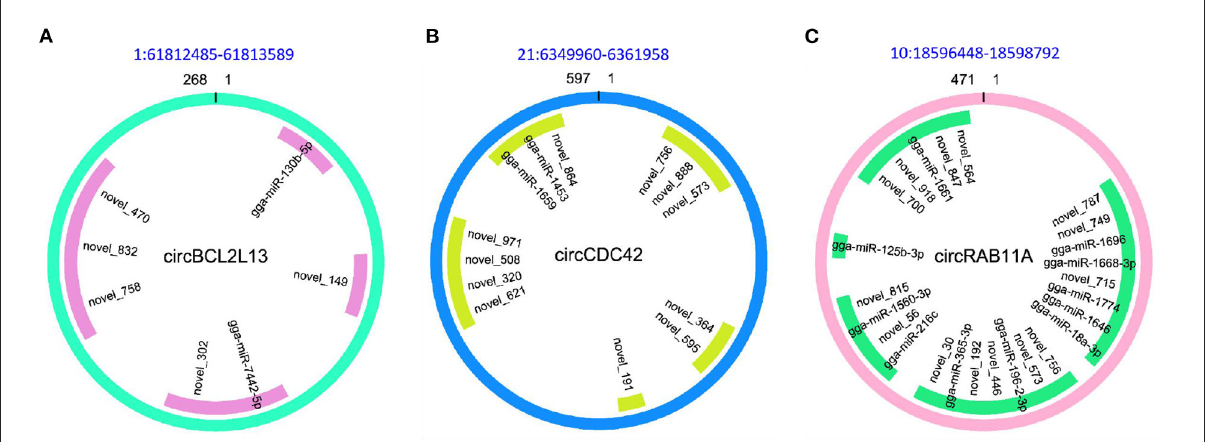
FIGURE6 The character of sequence pairing structure between circRNA and their target miRNAs. (A) circBCL2L13: gga-miR-130b-5p, novel_149, gga-miR-7442-5p, novel_302, novel_758, novel_832, novel_470. (B) circCDC42: novel_756, novel_573, novel_888, novel_364, novel_595, novel_191, novel_621, novel_320, novel_508, novel_971, gga-miR-1659, gga-miR-1453, novel_864. (C) circRAB11A: novel_787, novel_749, gga-miR-1696, gga-miR-1668-3p, novel_715, gga-miR-1774, gga-miR-18a-3p, gga-miR-1646, novel_756, novel_573, gga-miR-196-2-3p, novel_446, novel_192, gga-miR-365-3p, novel_30, gga-miR-216c, novel_56, gga-miR-1560-3p, novel_815, gga-miR-125b-3p, novel_700, novel_918, gga-miR-1661, novel_847,